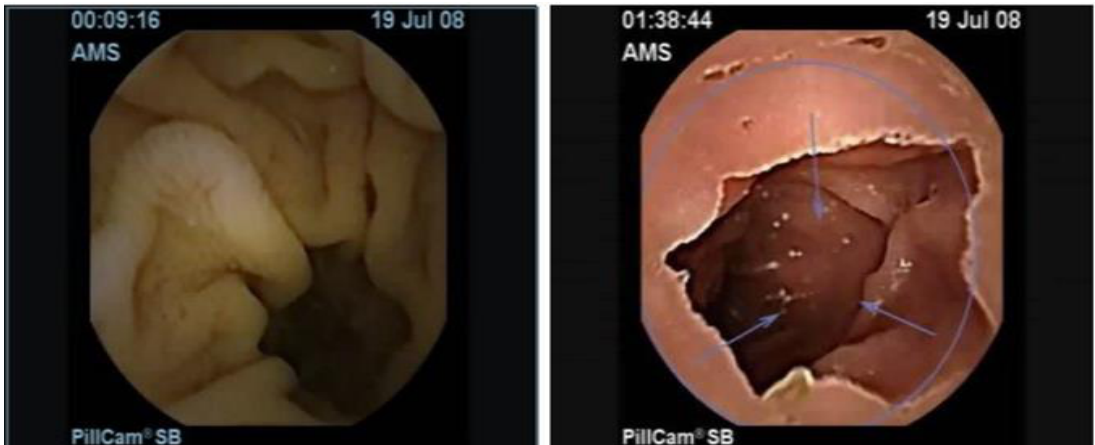
Figure 4. Sample ulcer images from WCE videos. ( Left ) esophageal ulcer; ( Right ) gastric ulcer.